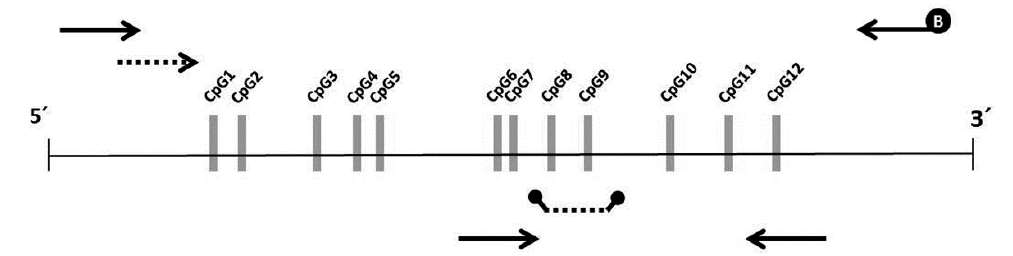
Figure 2. Representation of the CpG island analyzed located in the promoter of NEUROG1. The relative position of the 12 CpG sites is shown. Forward and reverse primers (solid arrows), and sequencing primer (dashed line) used for bisulphite pyrosequencing (B = biotin) is shown on the top of the figure. Forward and reverse primers (solid arrows), and probe (dashed line) used for the MS-qPCR is shown on the bottom of the figure.